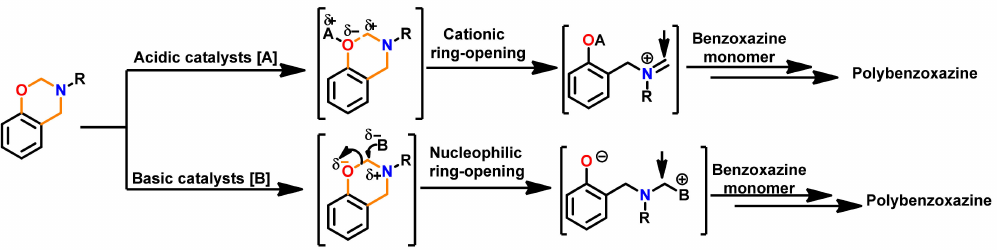
Figure 34. Proposed mechanism of ring-opening reaction in presence of acid and basic catalysts